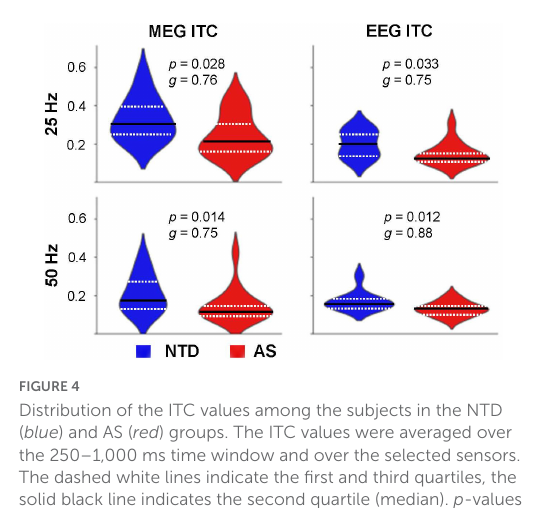
FIGURE4 Distribution of the ITC values among the subjects in the NTD ( blue ) and AS ( red ) groups. The ITC values were averaged over the 250–1,000 ms time window and over the selected sensors. The dashed white lines indicate the first and third quartiles, the solid black line indicates the second quartile (median). p -values (2-sided Wilcoxon rank-sum test, uncorrected) and effect sizes (Hedges’s g ) for the group differences are indicated for each